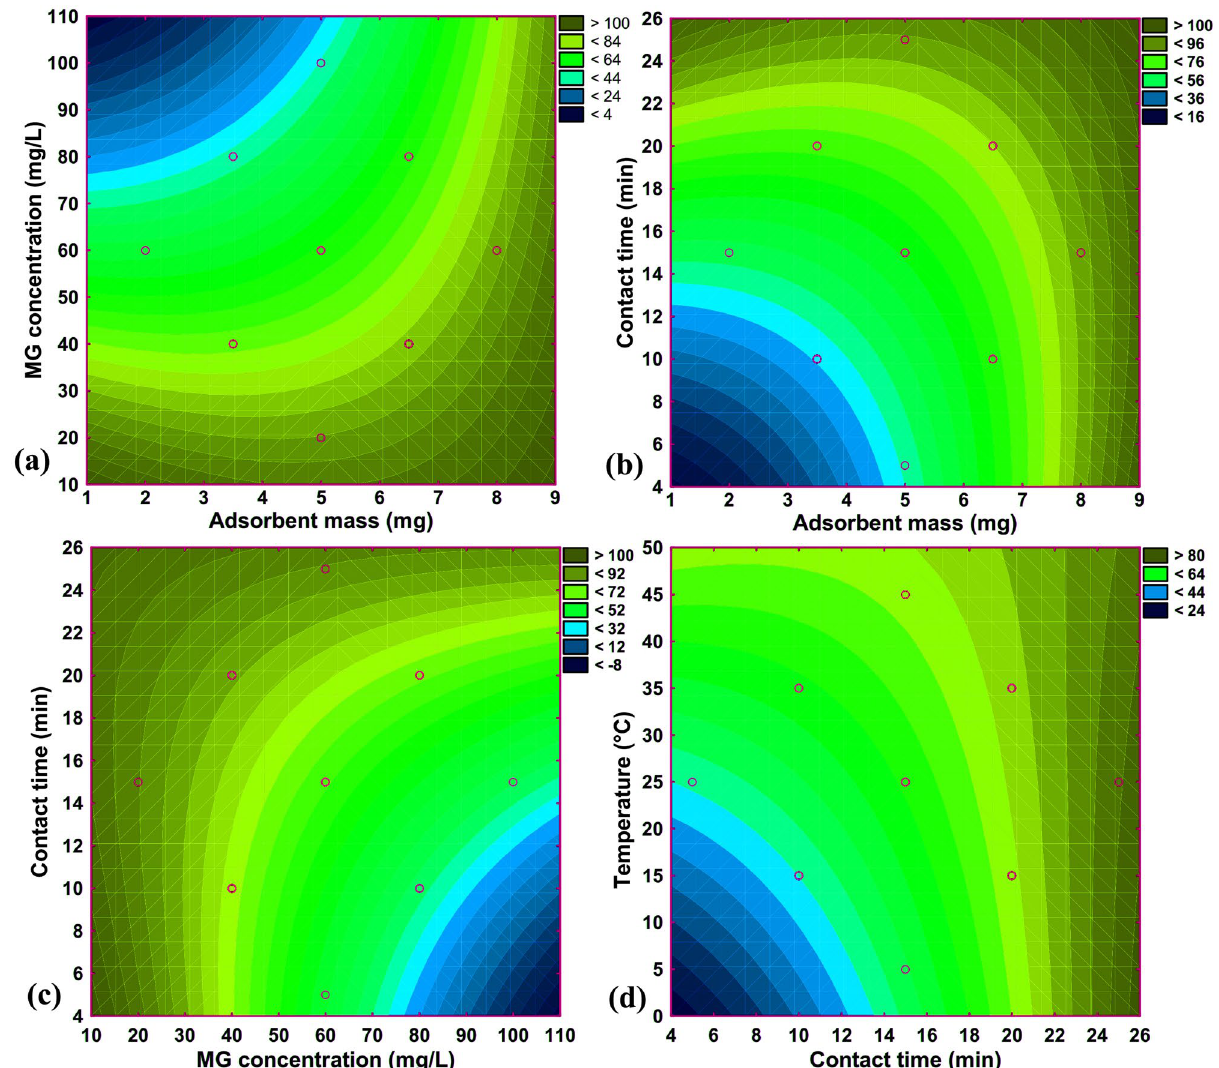
Figure 7. Contour plots showing the effects of ( a ) adsorbent mass-MG concentration, ( b ) adsorbent mass- contact time, ( c ) MG concentration-contact time, and ( d ) contact time–temperature on the R % of MG